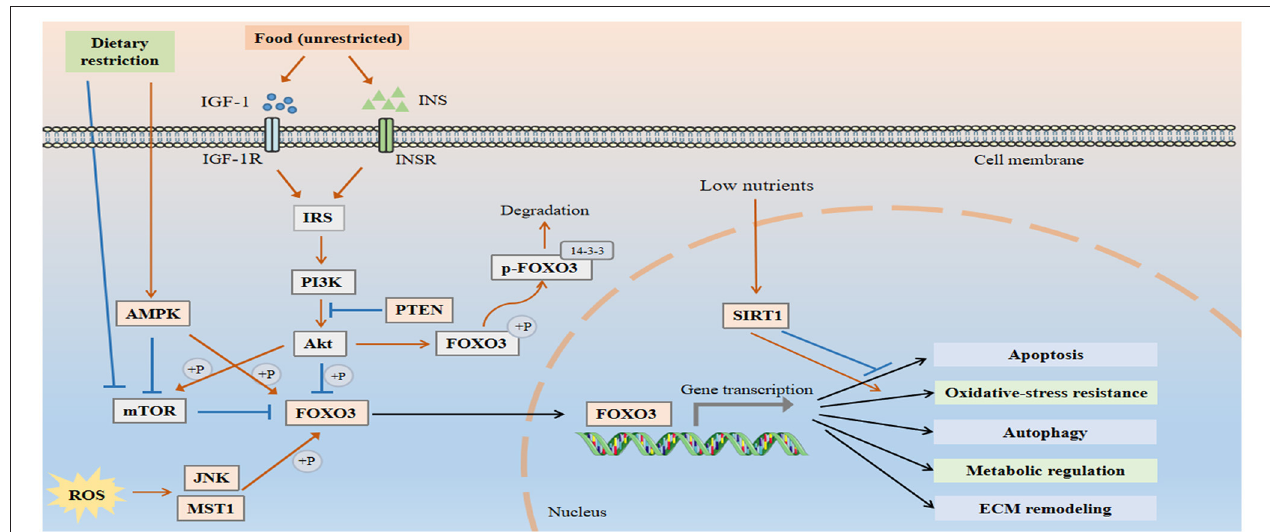
FIGURE 1 | FOXO3 is an integrator of multiple signaling pathways to maintain vascular homeostasis. Under normal conditions, FOXO3 is inactive due to the negative regulation by IIS-PI3K-Akt pathway. Akt phosphorylates FOXO3 at three highly conserved residues T32, S253, and S315, thereby establishing docking sites for the chaperone protein 14-3-3 and preventing it from re-entering the nucleus. PTEN antagonizes the effect of PI3K and induces FOXO3 activation. When cells are exposed to stress, including growth factor deprivation, metabolic stress, and oxidative stress, FOXO3 translocates into the nucleus and exhibits increased transcriptional activity. FOXO3 regulates a number of cellular processes, including apoptosis, autophagy, oxidative resistance, and metabolism, all of which are involved in the pathological process of vascular aging.